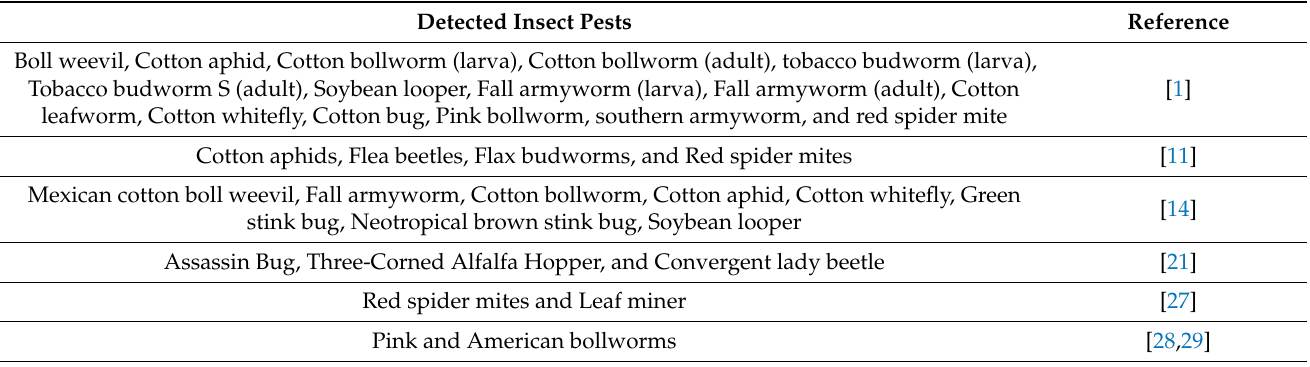
Table 3. Summary of recently detected cotton pests using